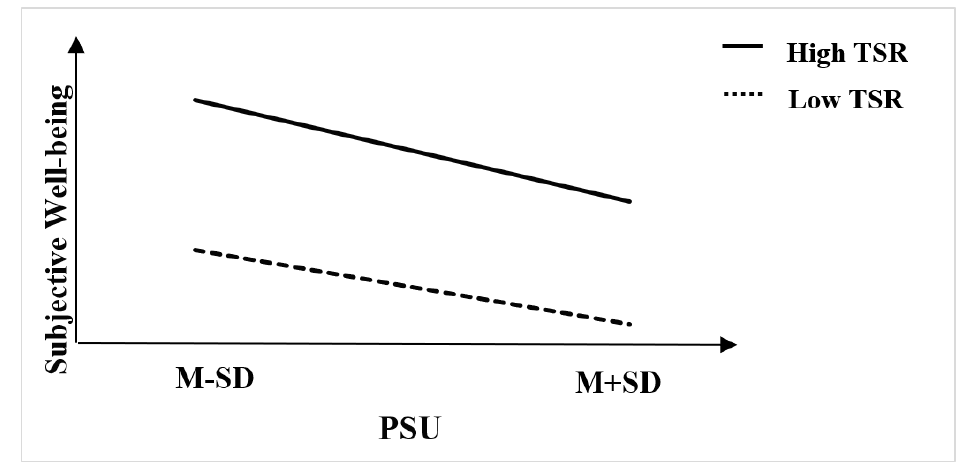
Figure 3. TSRs moderating PSU and